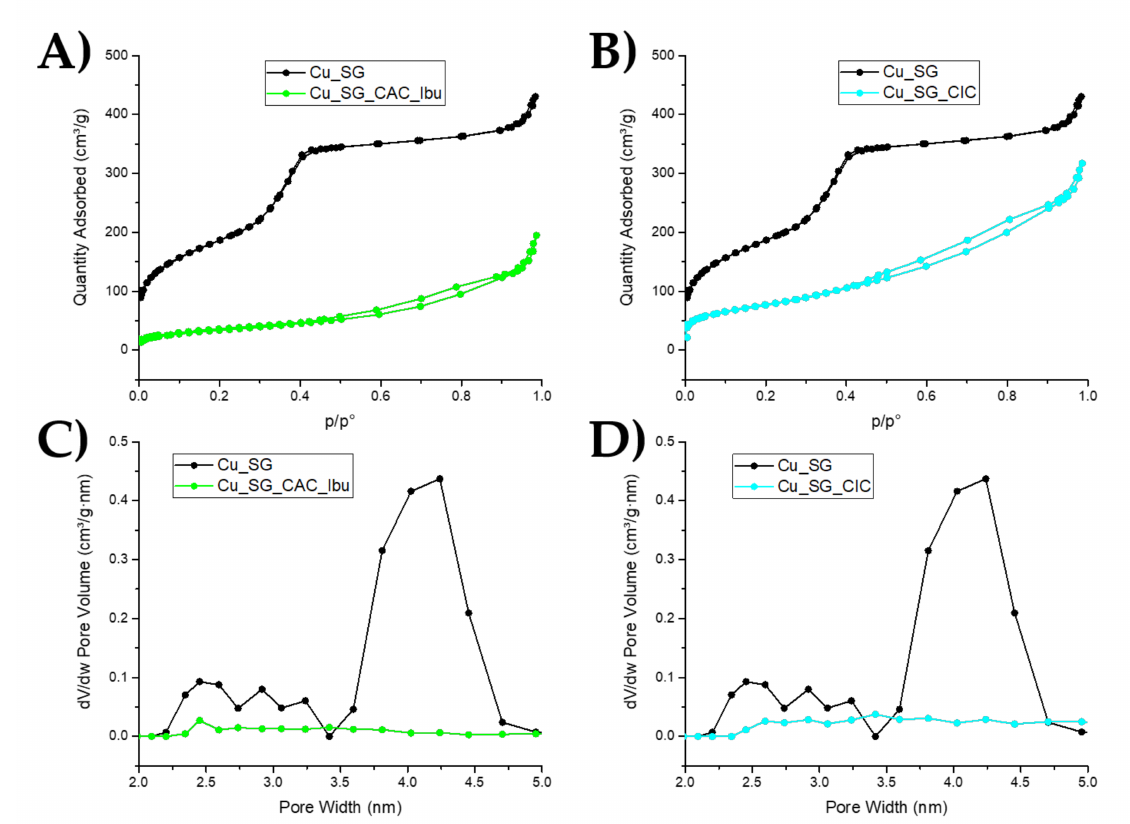
Figure 3. Type IV isotherm of ( A ) Cu_SG_CAC_Ibu and ( B ) Cu_SG_CIC and pore size distribution of ( C ) Cu_SG_CAC_Ibu and ( D )